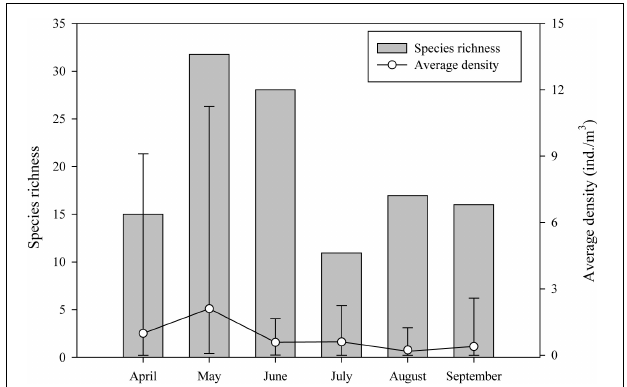
FIGURE 3 | Temporal distribution of the ichthyoplankton richness and average density (ind./m 3 ) ( n = 25 stations) from April to September 2019 by horizontal tows in Sansha Bay of Fujian Province, China. Error bars: maximum and minimum densities.